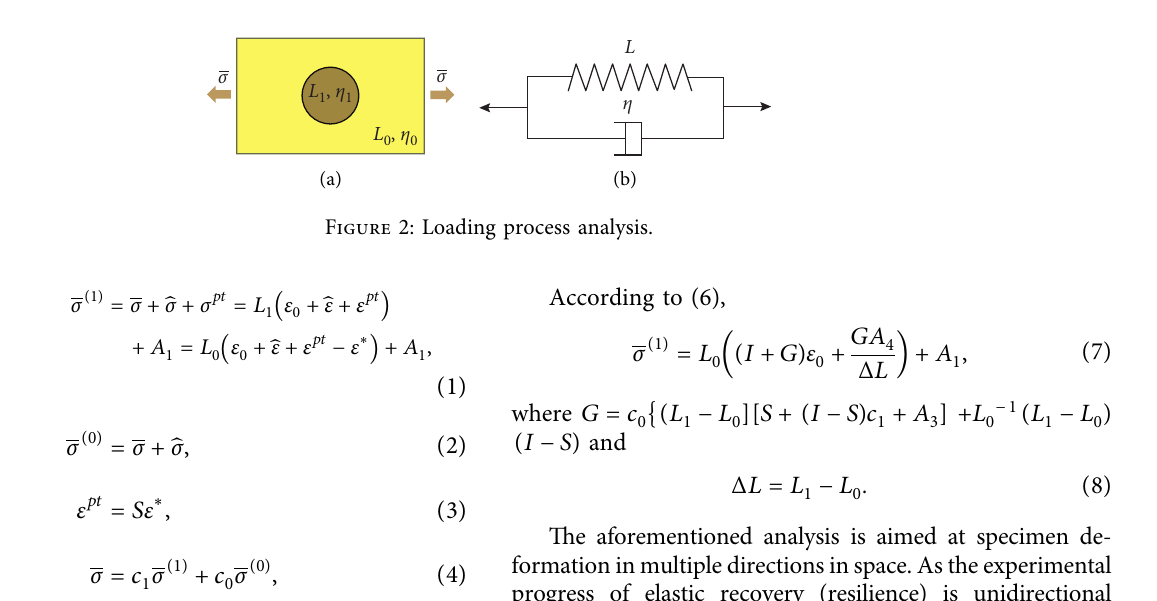
Figure 1: Schematic diagrams of detection mechanism for elastic recovery (resilience) experiment. (a) Elastic recovery experiment; (b) resilience experiment.